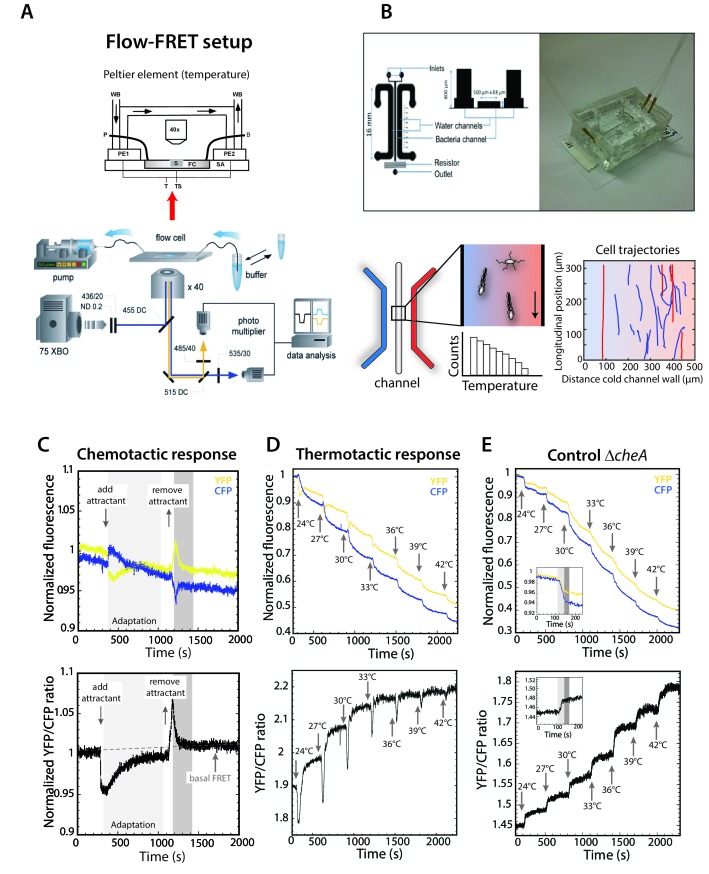
Thermotaxis assays for E.coli.(A,B) Schematic representations of the FRET microscopy (A) and microfluidics (B) setups used in temperature stimulation experiments. Lower right graph in (B) shows typical trajectories for cells swimming in the channel, where the distance to the cold channel wall (X-position) was used for calculating the TMC (see Materials and methods). (C–E) Examples of FRET measurements of response of wild-type cells to chemical attractants (C) and to temperature (D), with temperature response of ΔcheA shown as a negative control (E). Upper panels show fluorescence of individual YFP and CFP channels, while lower panels show the normalized YFP/CFP ratio. Arrows highlight 3°C stepwise increase to the indicated temperatures in FRET experiments. Insets in (E) for ΔcheA illustrate the direct effect of temperature on fluorescence of YFP and CFP and on the YFP/CFP ratio, respectively.